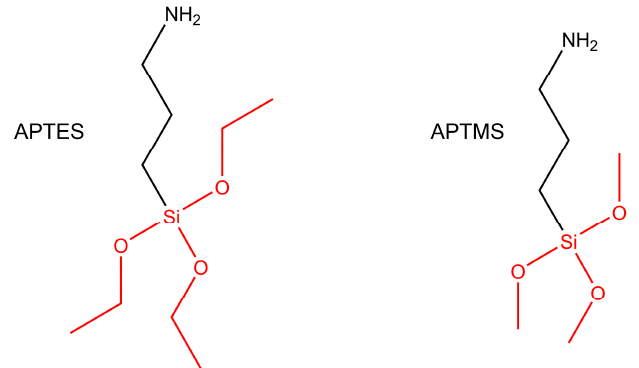
Figure 6. Molecules for Ni nanorod surface modification based on silane groups. The silane groups are shown in red. From left to right, these molecules are: (3-aminopropyl)triethoxysilane (APTES) and (3-aminopropyl) trimethoxysilane (APTMS).